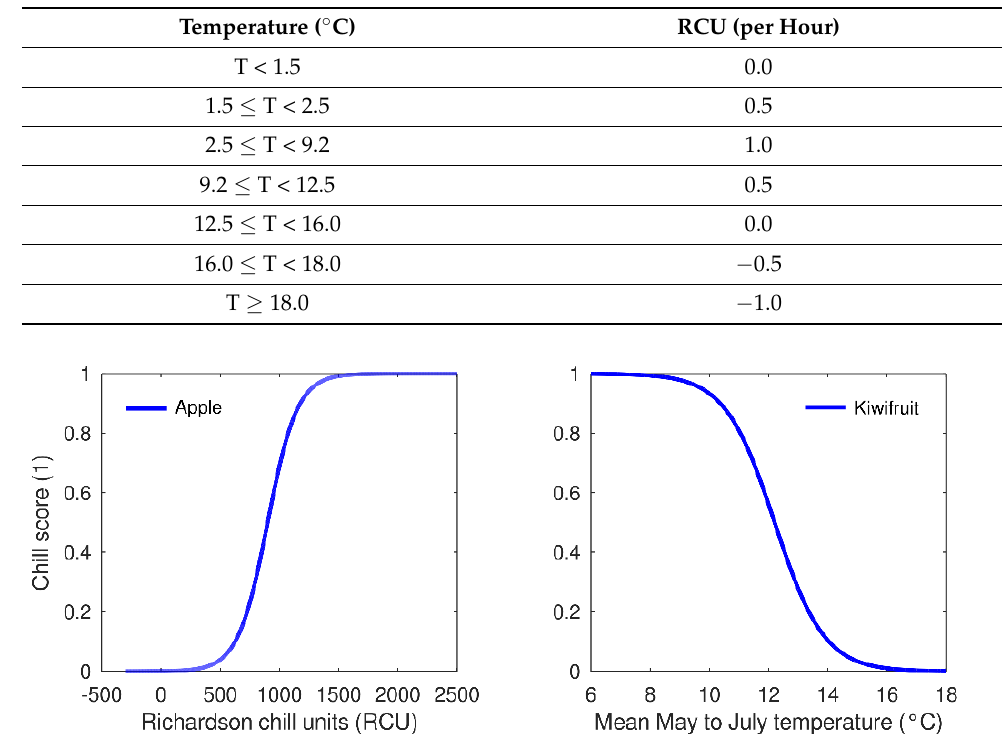
Figure 1 . Chill score curve for apple production ( left ) based on Richardson chill units (RCU) and kiwifruit production ( right ) based on mean May to July temperatures. A higher score indicates a more satisfactory chilling effect.